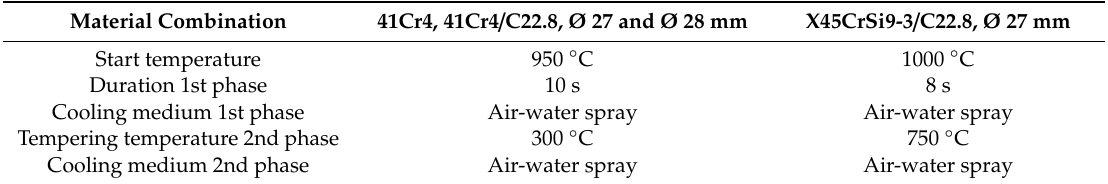
Table 1. Heat treatment parameters of the different hybrid bevel gears.